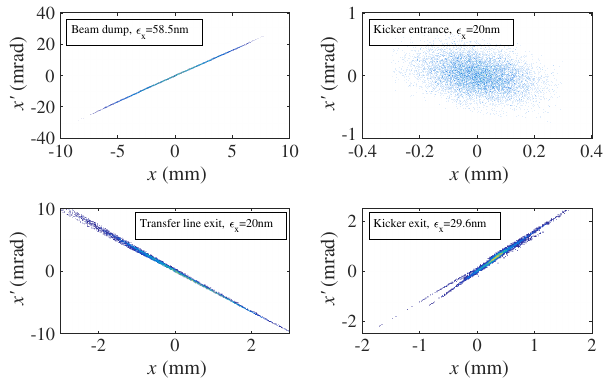
FIG. 12. Horizontal phase space at different locations.